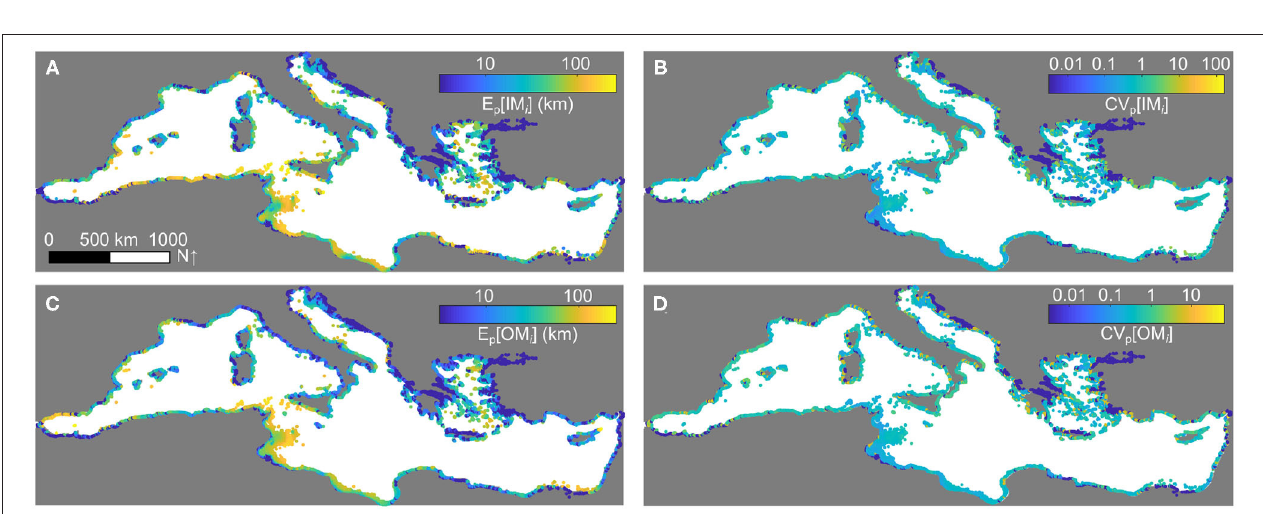
FIGURE 4 | Realized displacement patterns for P. oceanica . (A) Pooled average and (B) coefficient of variation of inbound displacement. (C) Pooled average and (D) coefficient of variation of outbound displacement. All quantities refer to the simulation of Figure 2 and are shown in log 10 scale.